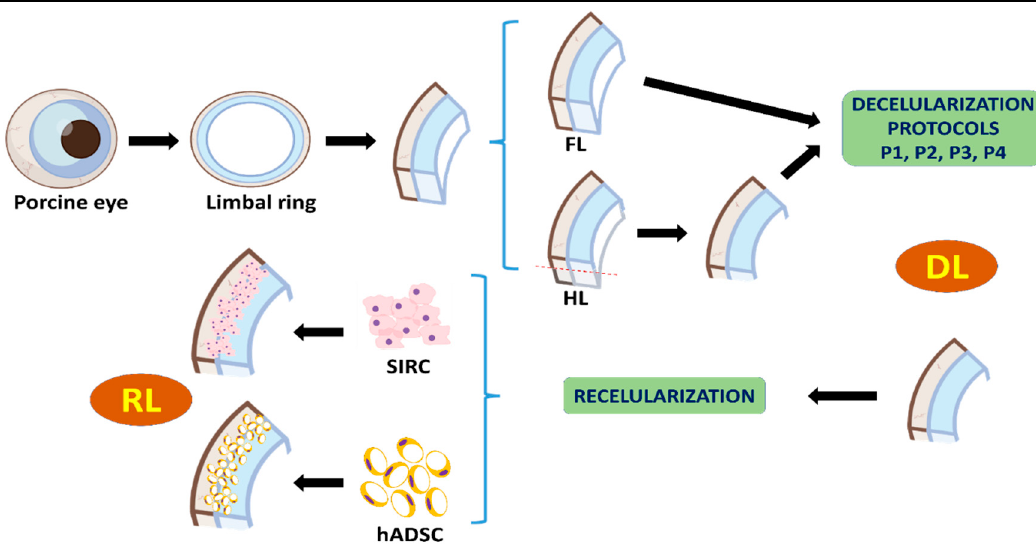
Figure 1. Schematic representation of the study protocol used in the present work. Fl: full-thickness limbus; HL: half- thickness limbus; DL: decellularized limbus; RL: recellularized limbus.